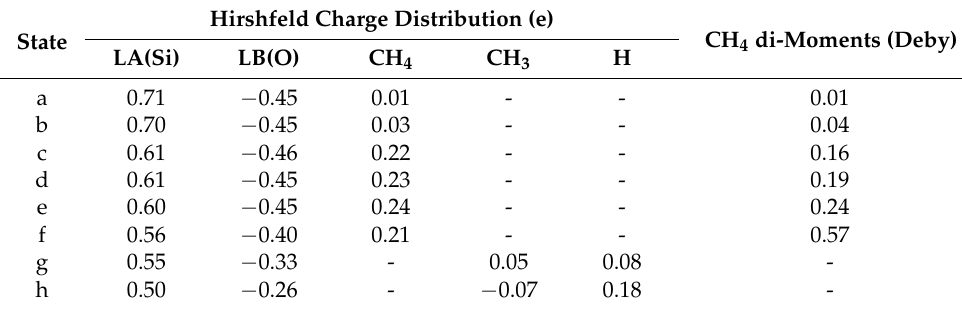
Figure 4. Surface dissociative adsorption process diagram of CH 4 on NaAlSi 3 O 8 (010) ( a – h ). Table 2. Hirshfeld charge distribution and dipole moments of the CH 4 dissociative adsorption process on the NaAlSi 3 O 8 (010) surface.